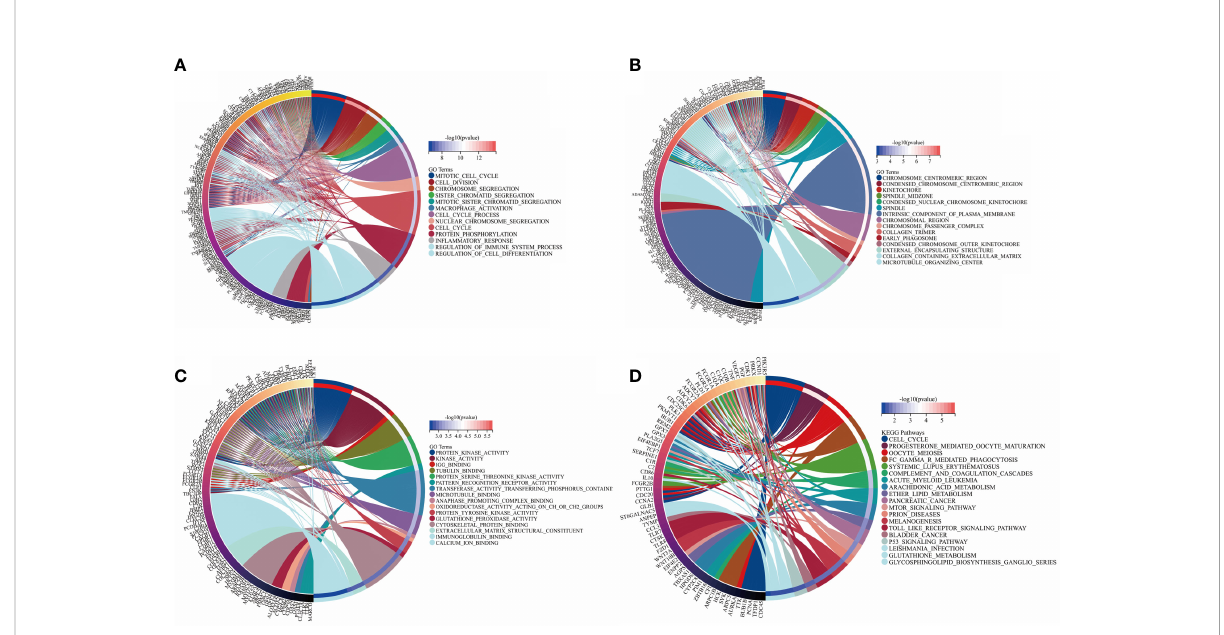
FIGURE 3 GO annotation and KEGG analysis of DEGs. (A) BP aspect; (B) CC aspect; (C) MF aspect; and (D) KEGG